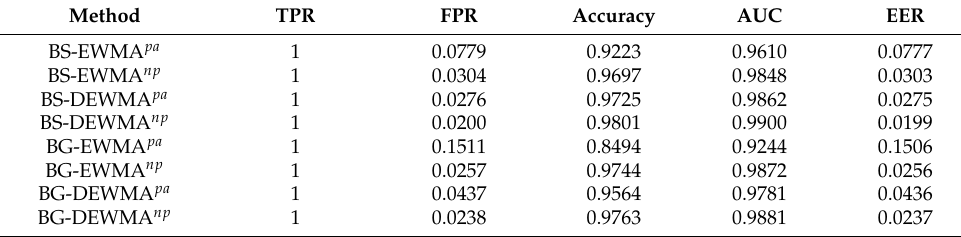
Figure 14. Results of the BG and BS-based schemes in monitoring inverter disconnections: ( a ) BG- DEWMA, ( b ) BG-EWMA, ( c ) BS-DEWMA, and ( d ) BS-EWMA schemes. Table 7. Detection results by procedure when inverter disconnections